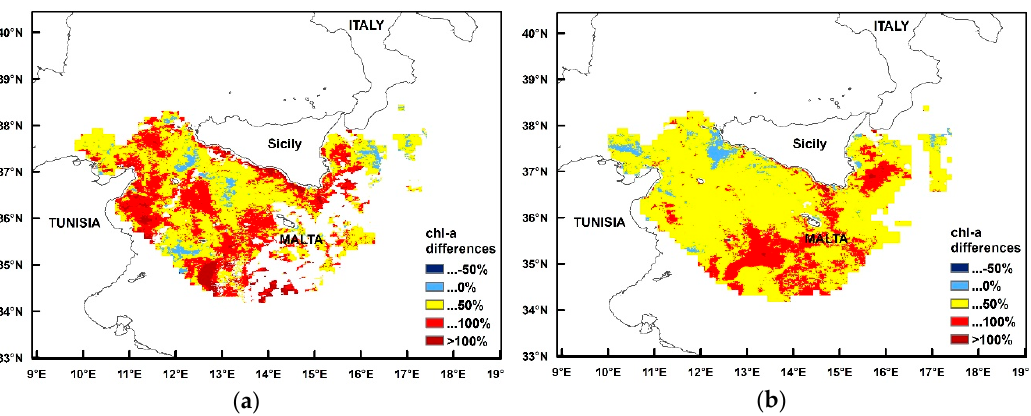
Precipitation sum for 6–8 November 2014.